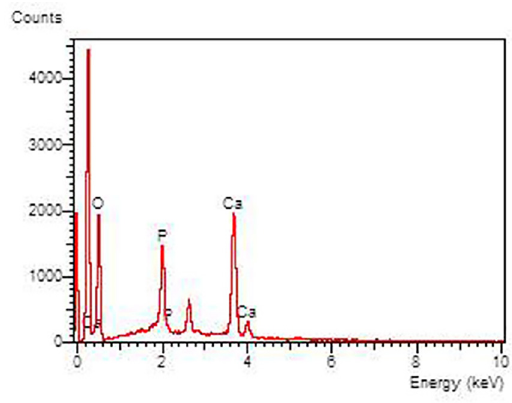
Figure 4. EDS spectrum of QNM.